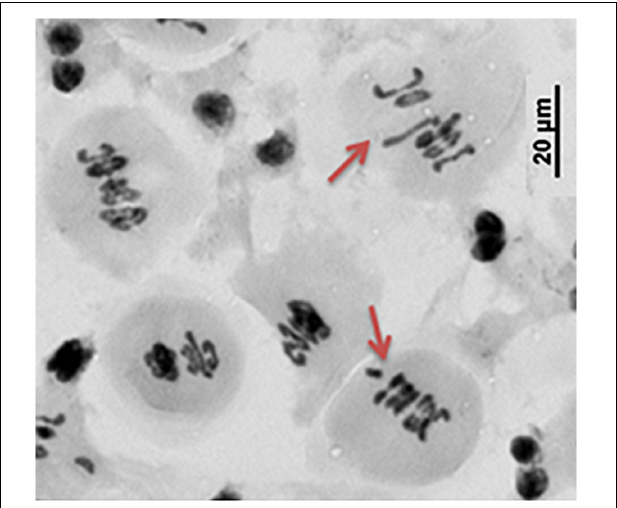
FIGURE 7 | The abnormal chromosome assembling during metaphase I in the dmc1.c-3223